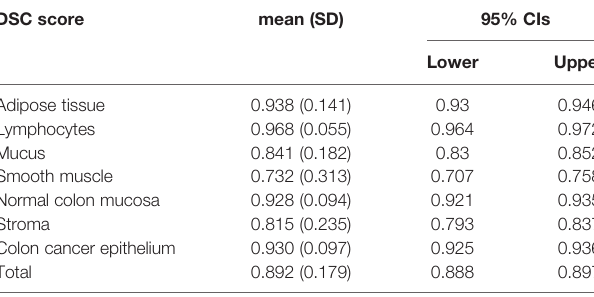
TABLE 2 | Predictive values of the PTS score for metastasis in colon